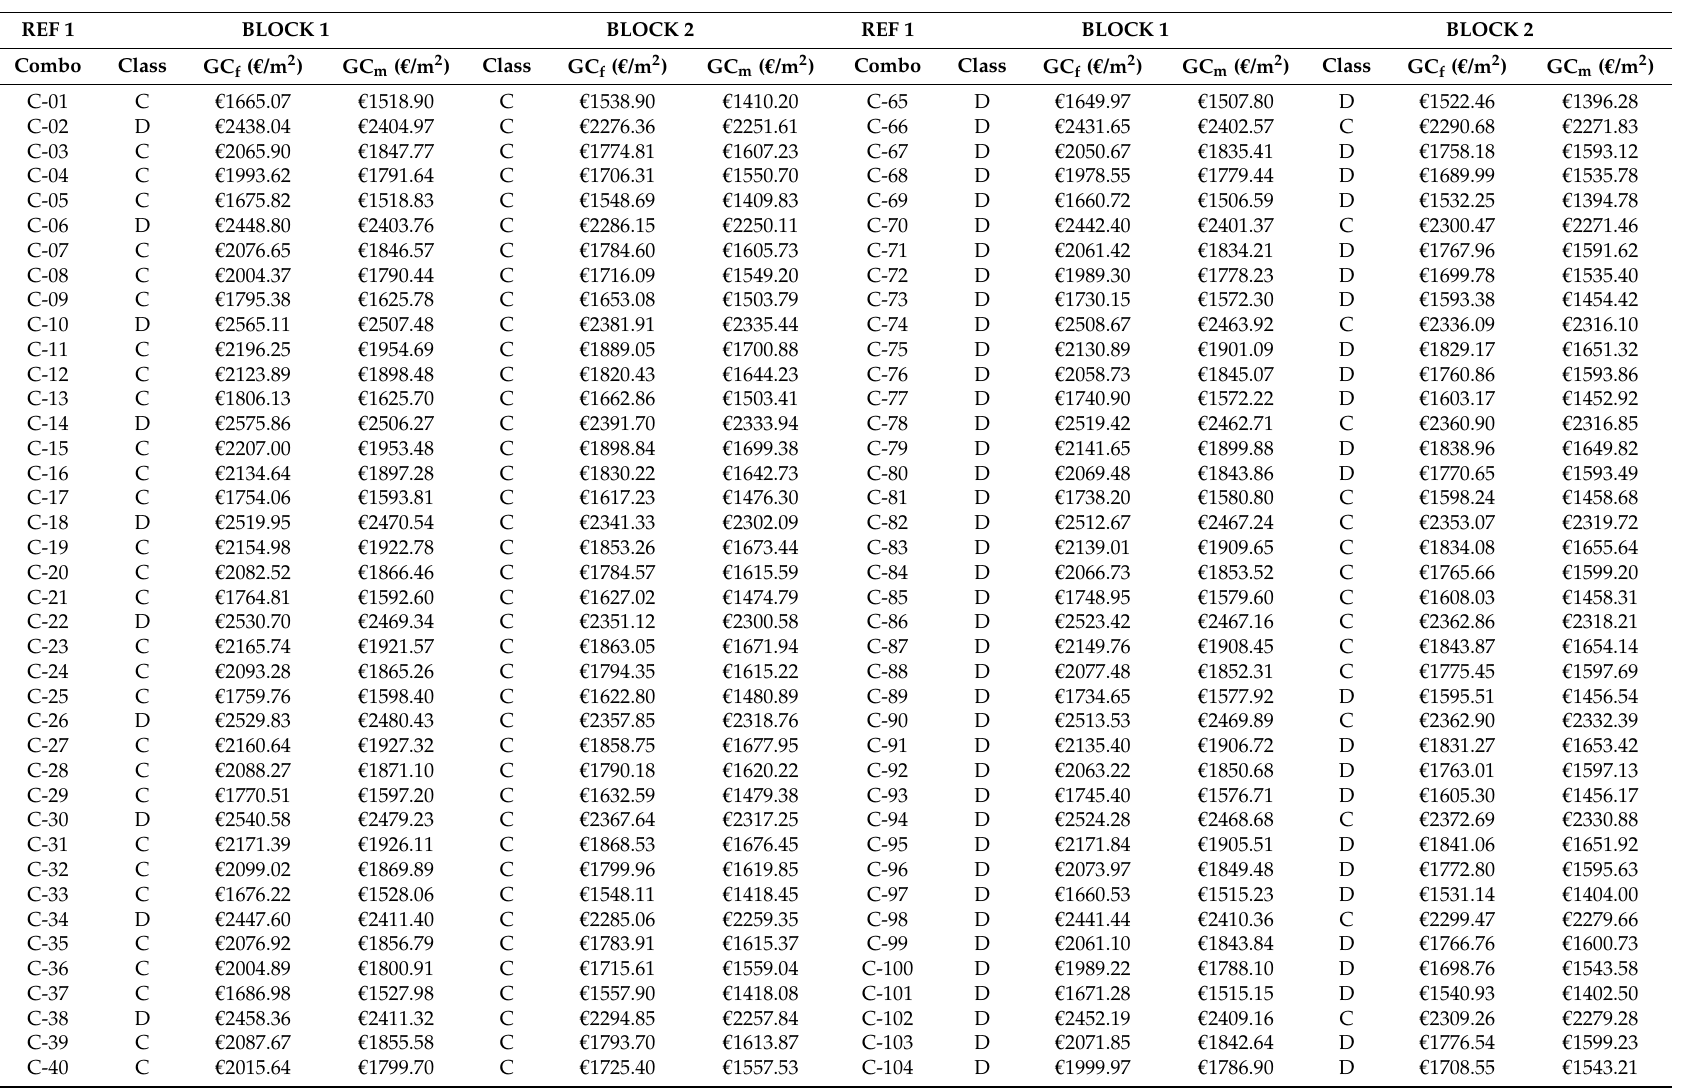
Table 10. Global cost for Reference building